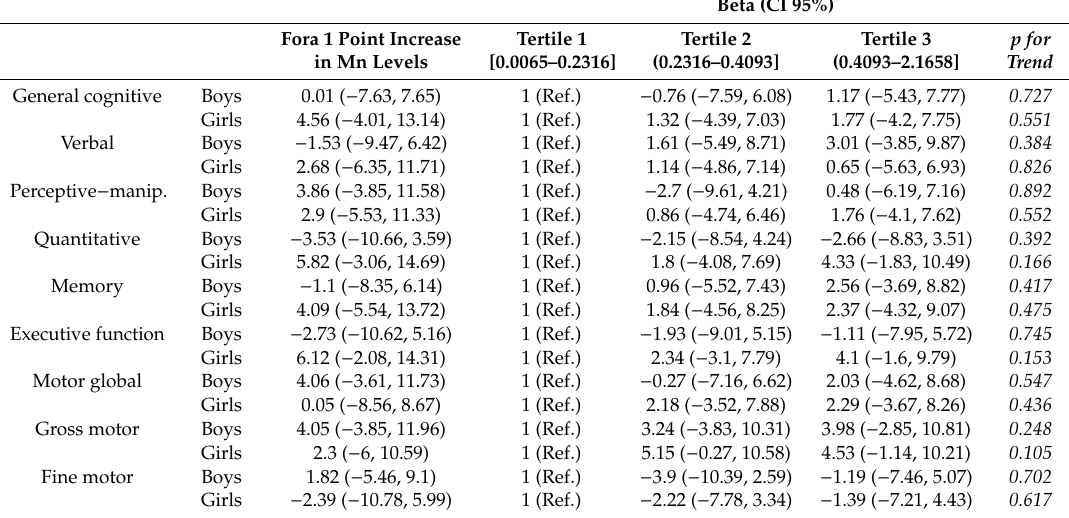
Table 3. Linear regression models for the association between Mn and McCarthy scale scores. Change in the McCarthy scale scorefor 1 µ g / g increase in Mn and bytertiles of the Mn distribution, stratified by sex of the child.